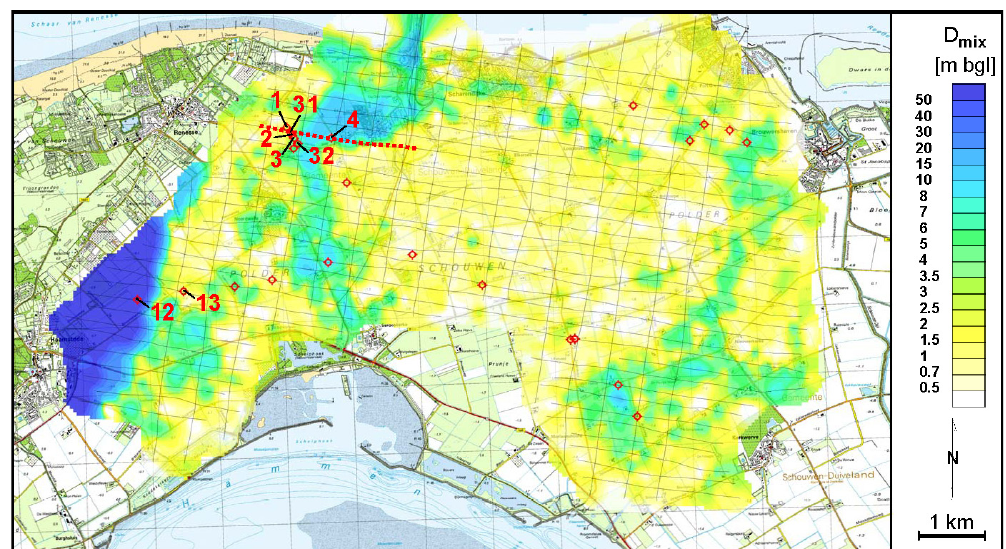
Fig. 14. Estimated depth D mix (average position of the mixing zone in m below ground level) derived from HEM inversion models. All flight lines (black lines) and the location of the ECPTs (red circles, those shown in Figs. 7 and 13 are numbered) are plotted on top of the depth map. The red dots indicate the position of the cross-section shown in Fig.